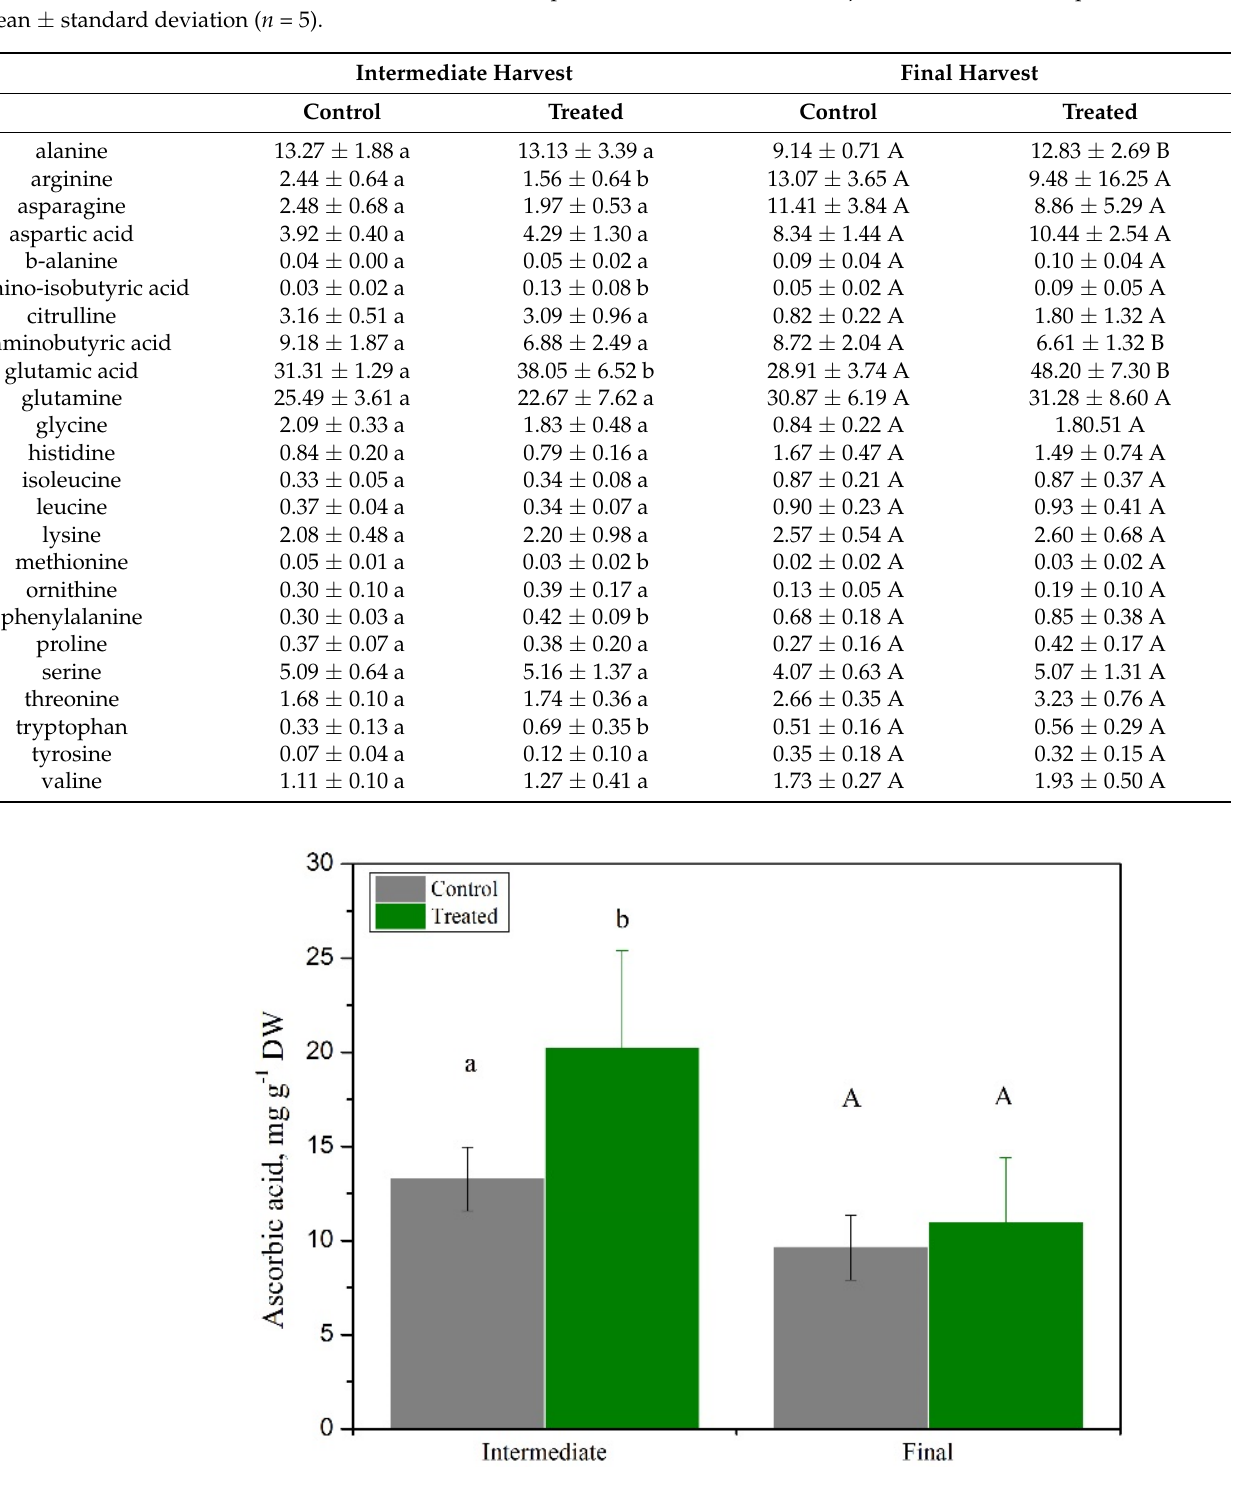
Figure 7. Ascorbic acid content of basil leaves grown as a secondary crop in the second experiment at the intermediate and final harvests. Values are expressed as mean ± standard deviation ( n = 5). Different letters indicate statistically significant differences between treatments at each harvest (small letters refer to the intermediate and capital ones to the final harvest, p < 0.05). Table 5 summarizes the macro- and micro-nutrient content of basil plants in the sec- ond experiment. Noticeable impacts of treatment were recorded in P concentration, with 40% and 52%, and Mn with 74% and 60% reductions in the intermediate and final har- vests, respectively; and in K, which showed a significant 45% reduction at the end of the experiment. On the contrary, Mg concentration was increased by 108% at the final harvest. Table 5. Nutrient concentrations in basil leaves of the control and cascade hydroponics treatments (2nd experiment) as determined at the intermediate and final harvests. Different letters indicate statistically significant differences between treatments at each harvest (small letters refer to the intermediate and capital ones to the final harvest, p < 0.05). Values in all layers are expressed as mean ± standard deviation ( n = 10). Intermediate Harvest Treatment